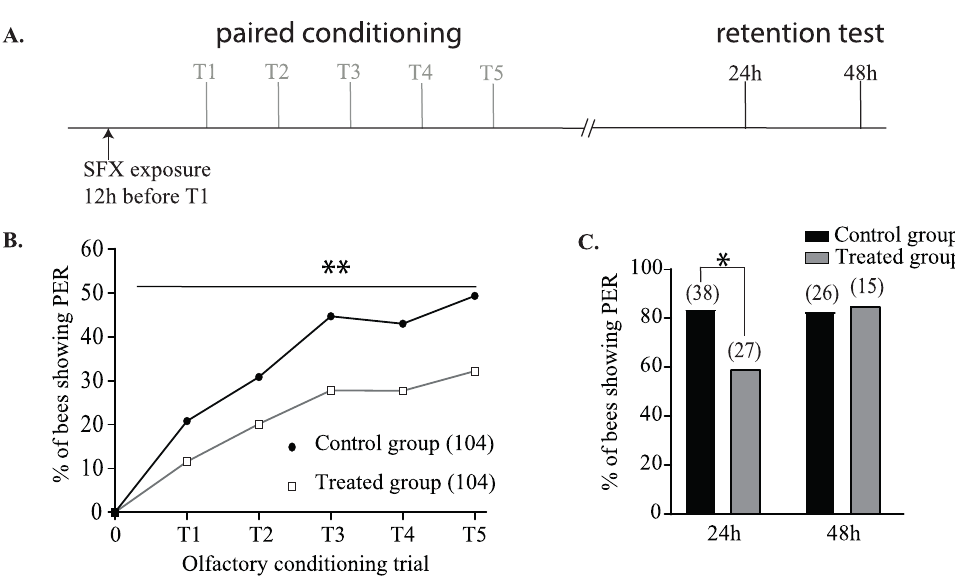
Fig 4. Effect of sulfoxaflor sublethal dose on learning ability and memory formation after exposure 12 h before conditioning. A . Experimental procedure used: 12 h before the first olfactory conditioning trial (T1), treated and control bees received 2 μ L of SFX solution (15 ng/bee) or 50% (w/v) sucrose solution respectively. B . The response (PER or no PER) of each bee was registered during each conditioning trial. Only surviving bees showing a proboscis extension response at the end of the olfactory conditioning were considered for the restitution test. C . The restitution tests were performed 24h and 48h after the last olfactory conditioning trial. Asterisks indicate statistically significant differences in the treated group response compared to the control group (P < 0.05). The number of individuals in each group is given in the brackets.